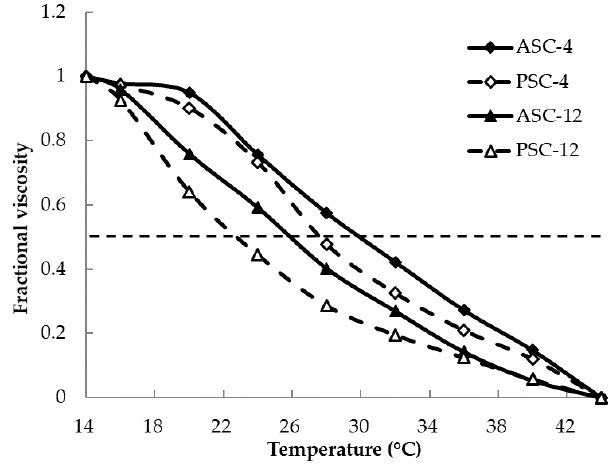
Figure 7. Thermal denaturation curve of ASC and PSC extracted at 4 and 12 °C from the skin of pufferfish.